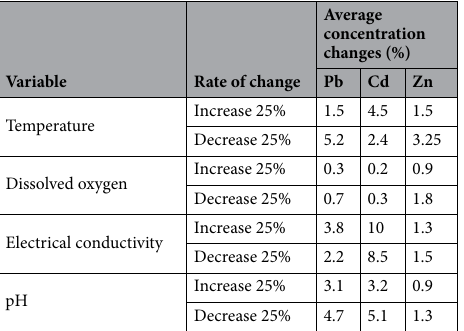
Table 8. Analysis of the sensitivity of heavy metal concentration to the quality parameters in